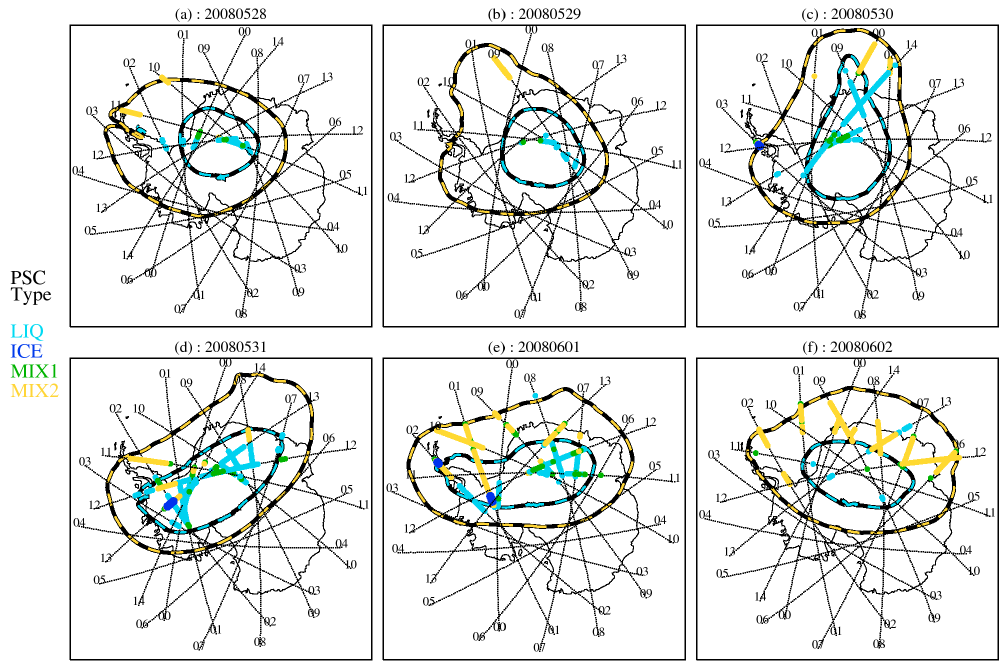
Fig. 12. Geographic distribution of the CALIOP PSC types detected at an altitude of 22km from 28 May–2 June 2008, (a)–(f) . Highlighted contours are the NAT existence threshold temperature (approximately T ICE + 7 . 5K, yellow-black dashed) and STS formation temperature ( T ICE + 3 . 5K, cyan-black dashed) calculated from the GEOS-5 temperatures and MLS HNO 3 and H 2 O at 32hPa. CALIOP detected ICE from 30 May–1 June over the Antarctic Peninsula and the Ellsworth Mountains. Black dots are observations without PSC detections.